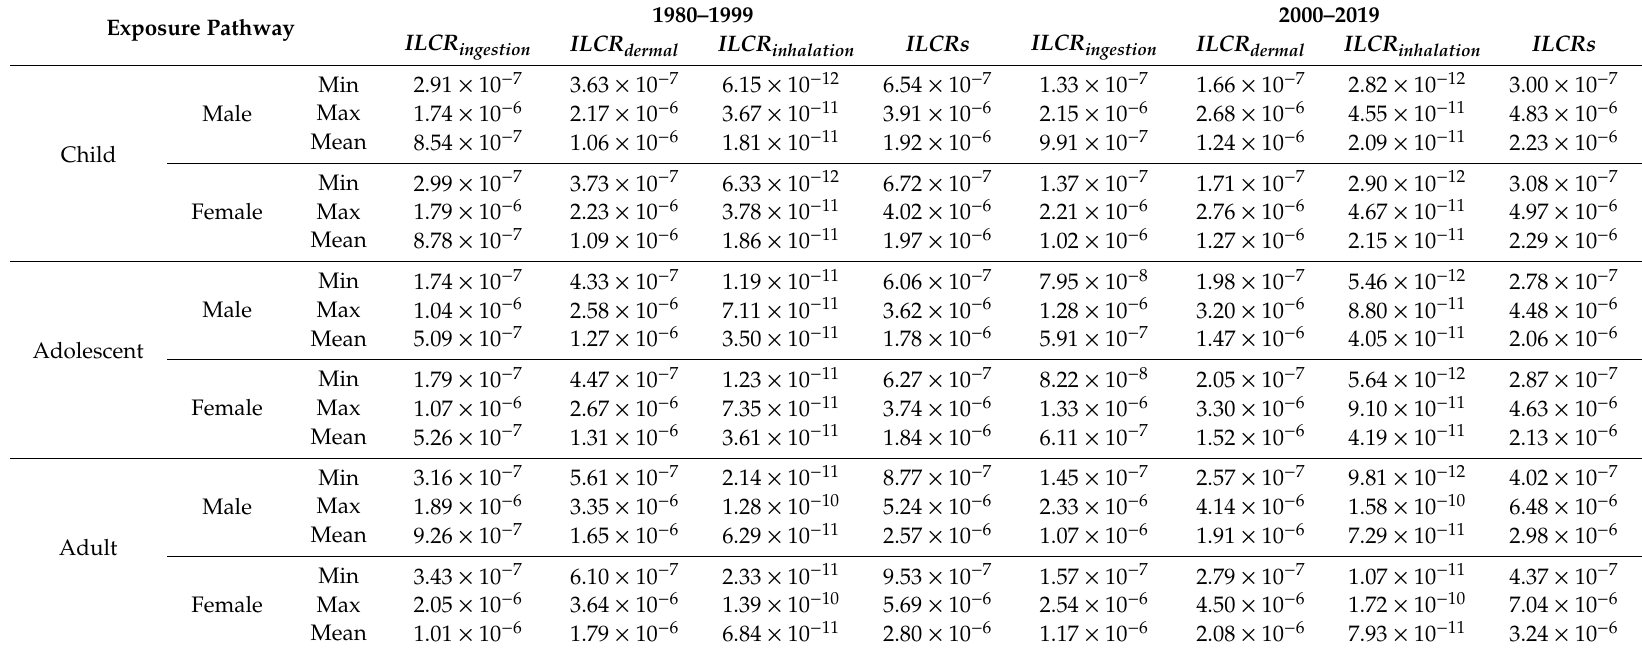
Table 2. The ILCRs of people for di ff erent exposure